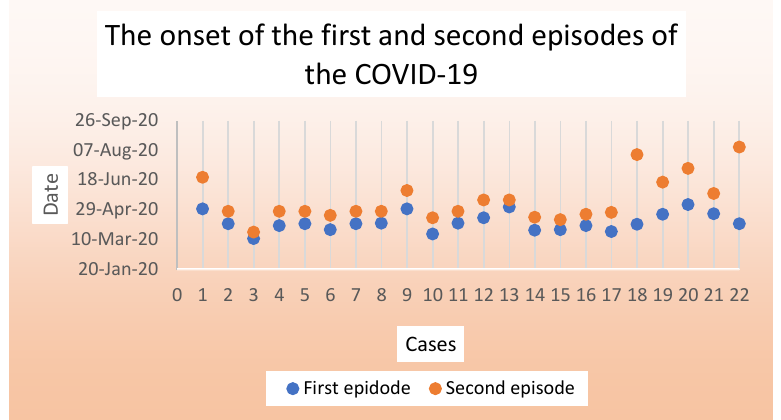
Figure 1. The onset of the first and second episodes of COVID-19.